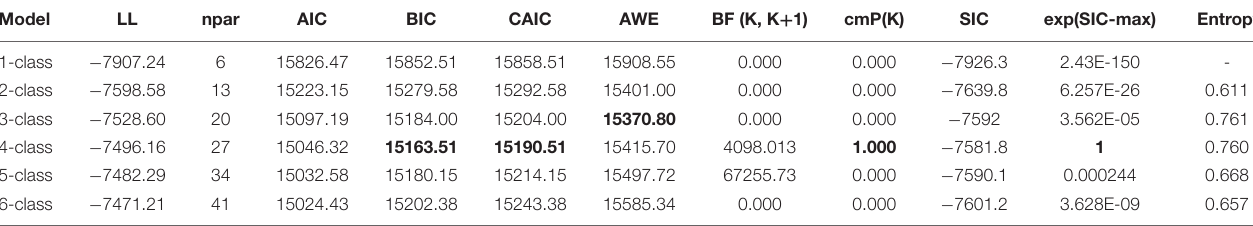
TABLE 3 | Latent class solution of student behaviors at the year